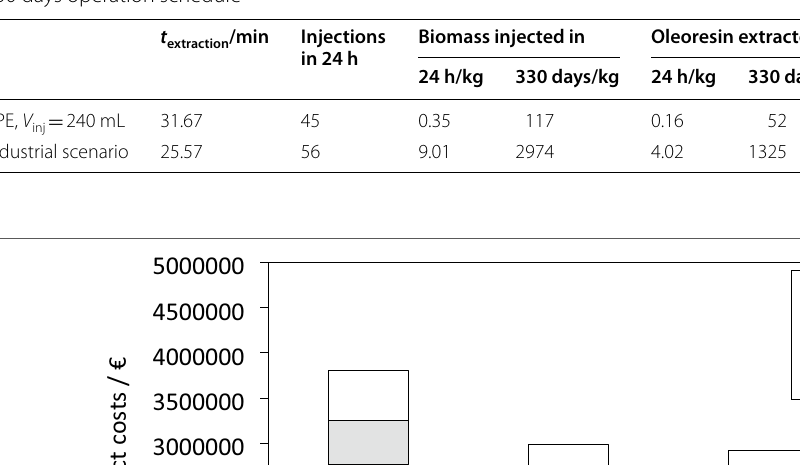
Table 3 Injected amount of biomass, extracted amount of oleoresin and astaxanthin and required number of CPE units in a 24 h and